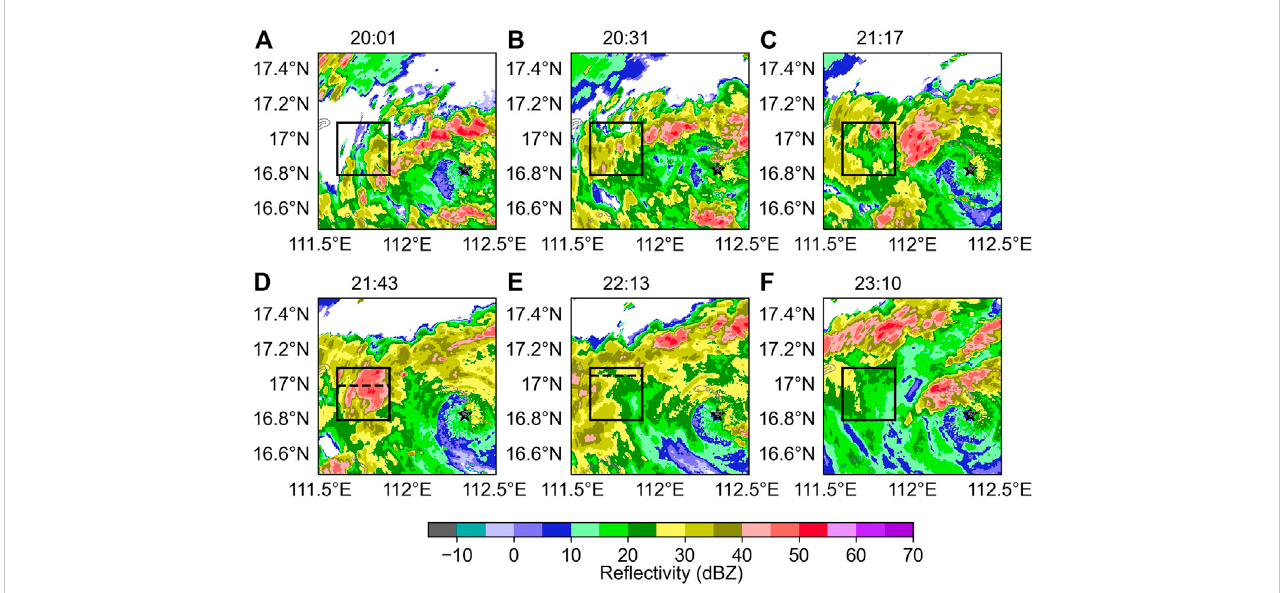
FIGURE 2 Distribution of composite re fl ectivity (units: dBZ) at (A) 20:01, (B) 20:31, (C) 21:17, (D) 21:43, (E) 22:13, and (F) 23:10 on 16 October. The black square denotes Region 1 (the same